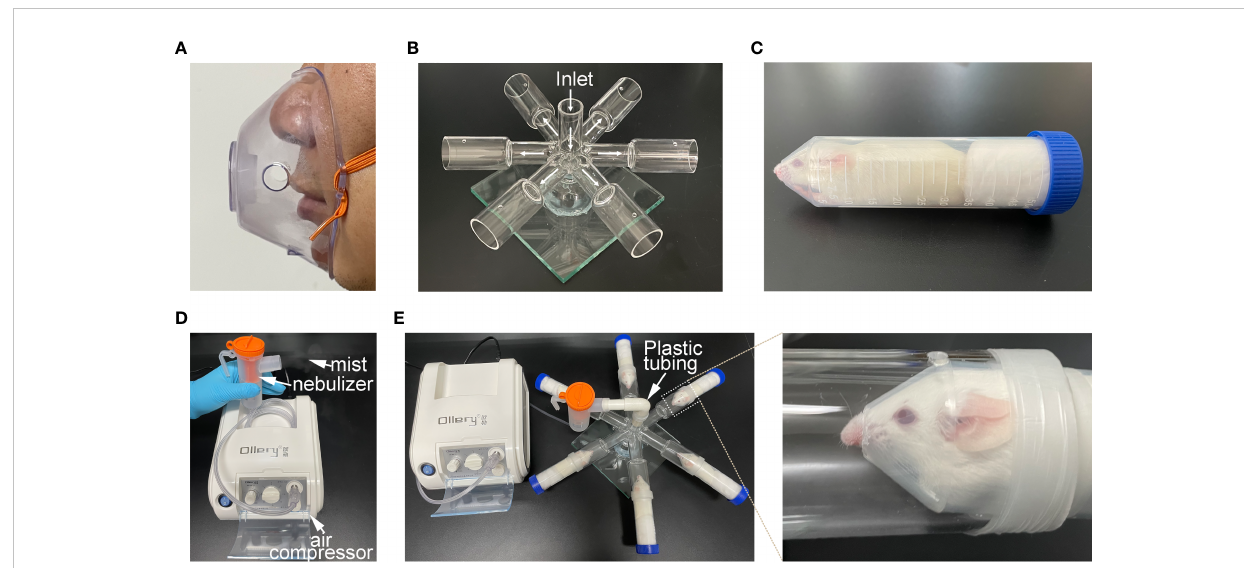
FIGURE 1 Construction of atomization inhalation system for mice. (A) atomization inhalation mask commonly used by human beings. (B) Six-way pipe inhalation chamber for mice depicting the fl ow pattern of the aerosol. This chamber consisted of three parts (inlet pipe, six-way pipe and base fi xing device). (C) Holding chamber for mouse. (D) medical/household air compressor and nebulizer set-up. (E) Working diagram of mouse atomization inhalation